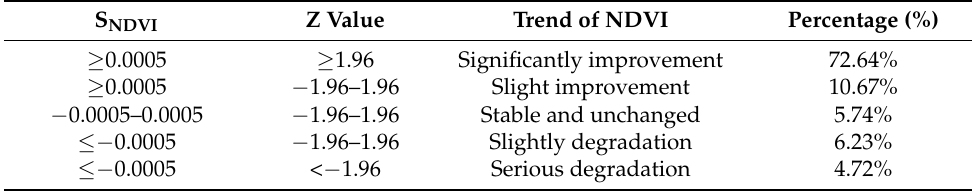
Table 4. Statistics of NDVI trend in Yangtze River